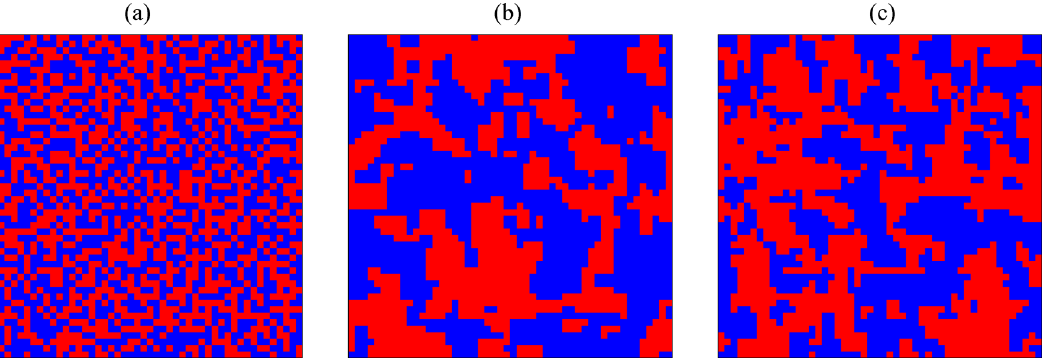
Figure 2. Snapshots of traffic signals under different control methods. ( a ) Local controller using Eq. (11), ( b ) Global controller optimizing Eq. (10) with the simulated annealing, and ( c ) Global controller optimizing Eq. (10) with the D-Wave 2000Q. Red and blue dots represent vertical and horizontal directions allowed at each crossing, respectively. Parameters α , η , and L are fixed as α = 0.8, η = 1.0 , and L = 50 , respectively. For the D-Wave method, the Hamiltonian is divided into 42 groups and the optimization problem is solved in parallel. See “Methods” for details. (The data are plotted with software Python/matplotlib).